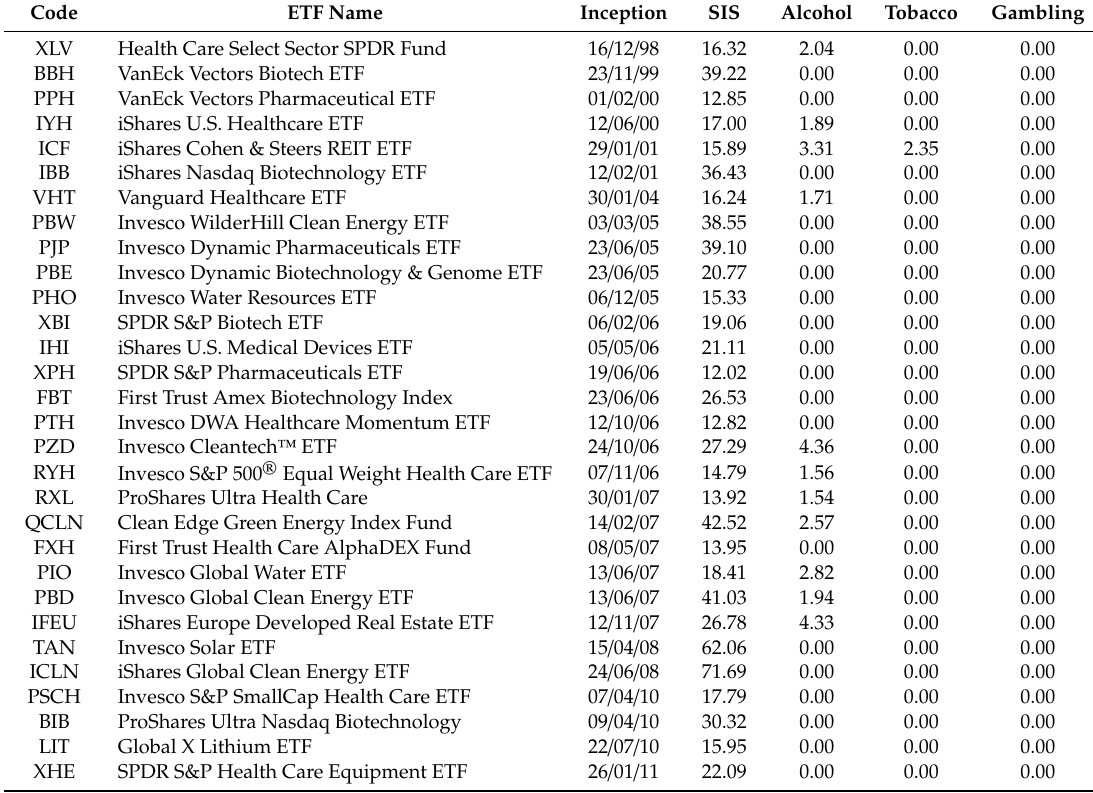
Table 1. Profile of socially responsible exchange traded funds